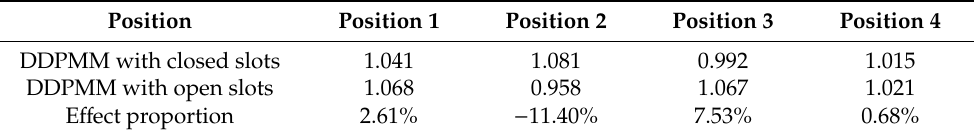
Table 2. Fundamental amplitudes of air-gap flux density at di ff erent positions.